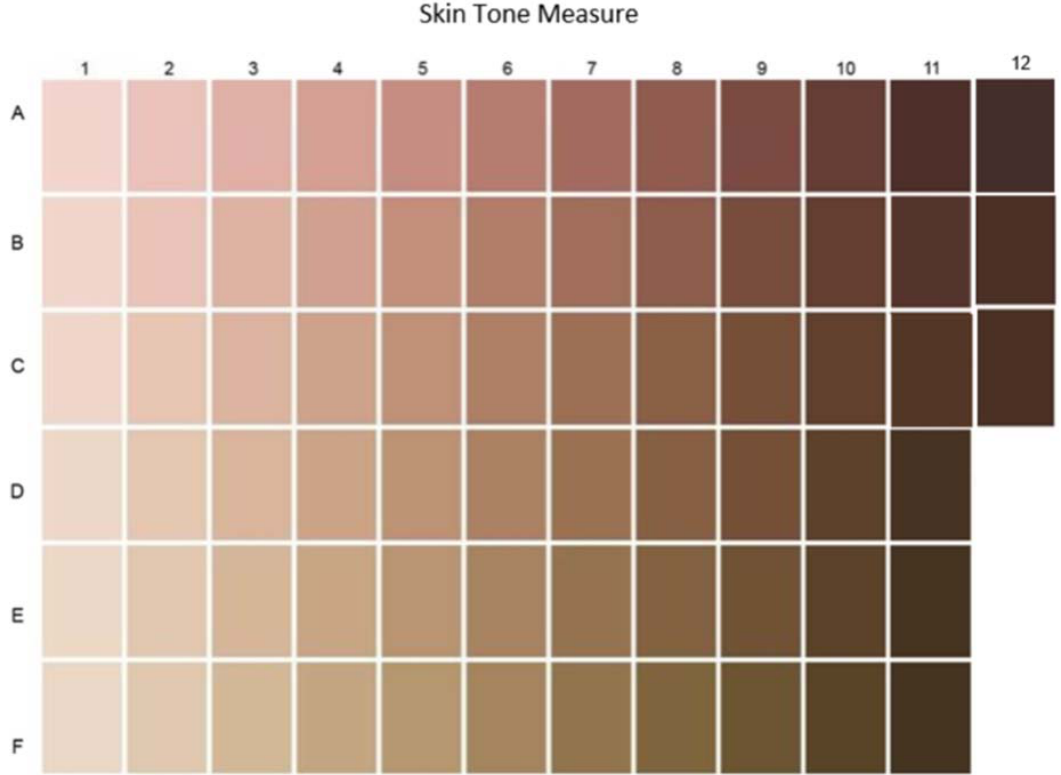
Figure A1. This two ‐ axis color grid was created by Campbell et al. (2020) to include a greater variety of skin tones than those presented in the White ‐ to ‐ Black skin tone continuum provided by many skin tone measures. In addition to more adequately including other racial and ethnic groups’ range of skin tones, this measure offers a greater variety of darker skin tones than most contemporary measures incorporate.